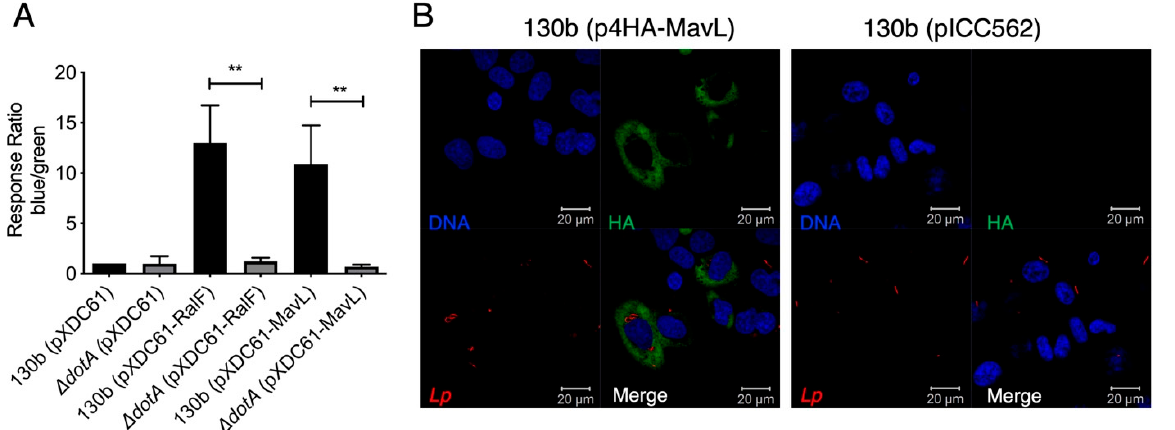
Figure 1. Translocation and localization of the Dot/Icm effector MavL during L. pneumophila infection. ( A ) TEM1-based translocation of L. pneumophila expressing a TEM1-MavL translational fusion compared to an isogenic Δ dotA derivative. Translocation is expressed as a response ratio of blue/green fluorescence, with background fluorescence subtracted and normalized against fluorescence seen in cells infected with L. pneumophila carrying the empty pXDC61 vector. TEM-RalF translocation was used as a positive control. Error bars represent the standard error of the mean (** denotes p < 0.01, unpaired two tailed t -test) of three biological repeats. ( B ). Immunofluorescence imaging of HEK-293 Fcr γ cells infected with L. pneumophila 130b (pHA-MavL) for 16 h; 4HA-MavL expression was induced with the addition of IPTG prior to infection (green); L. pneumophila 130b carrying pICC562 (empty vector) was used as a negative control for HA-staining. Bacteria were visualized with anti- L. pneumophila antibodies (red), DNA was visualized with Hoechst stain (blue).